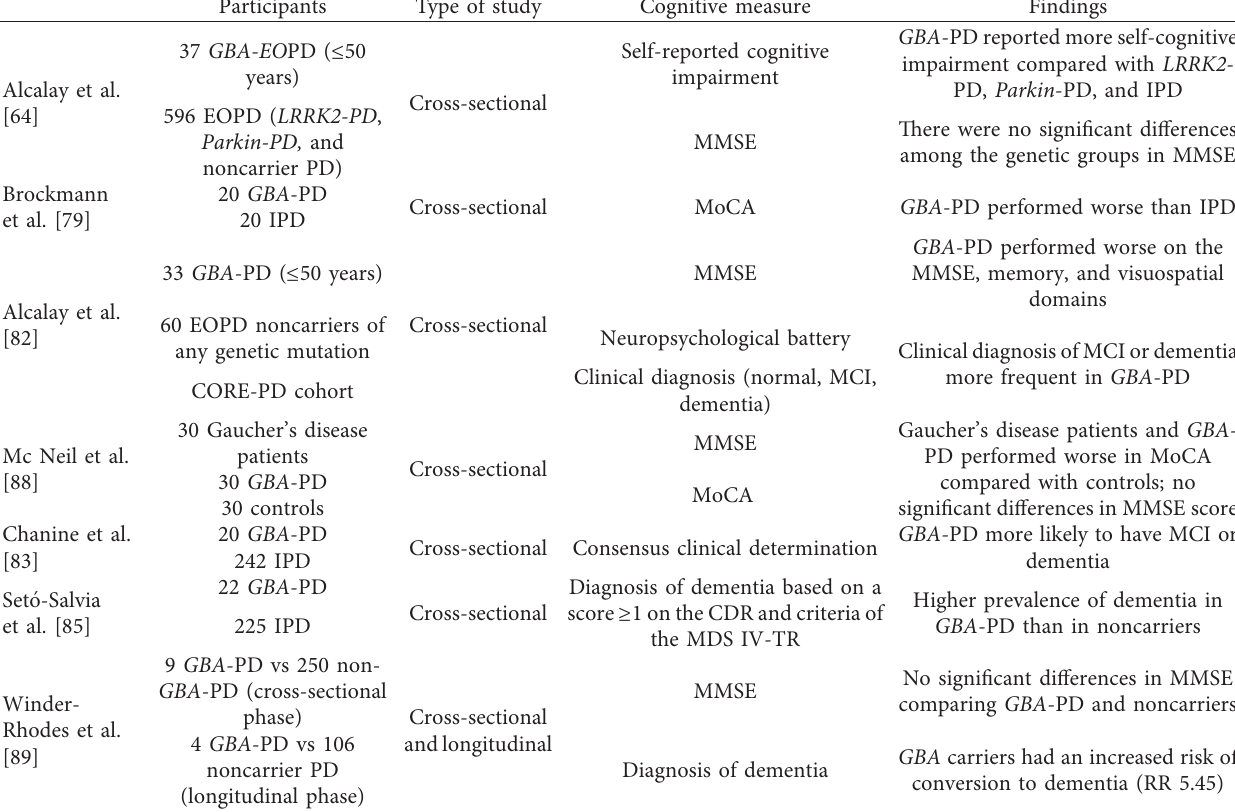
Table 3: Studies assessing cognitive function in GBA -associated PD.